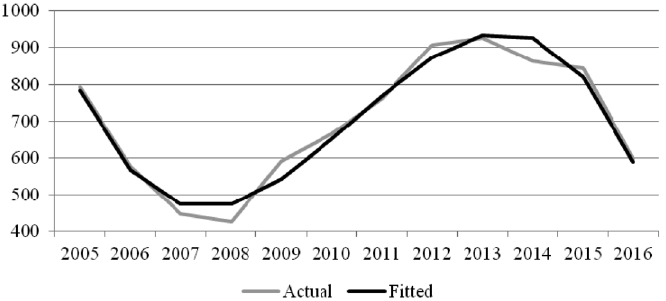
Figure 1. Actual and fitted values of the number of bankruptcy of enterprises in Poland obtained on the basis of the trend models (source: Own work)